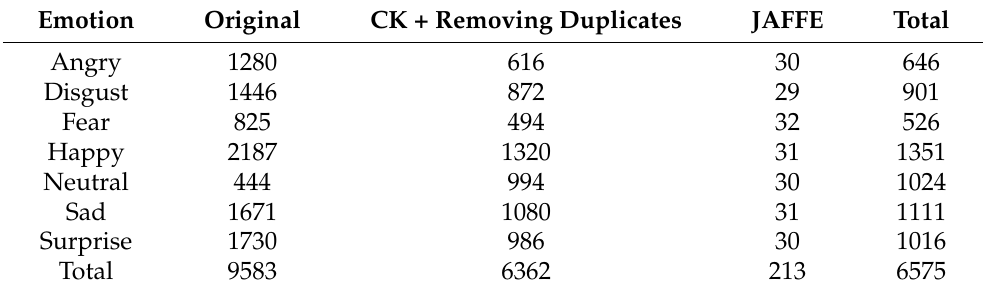
Table 3. Number of images according to the emotions in CK+ and JAFFE database original and after removing